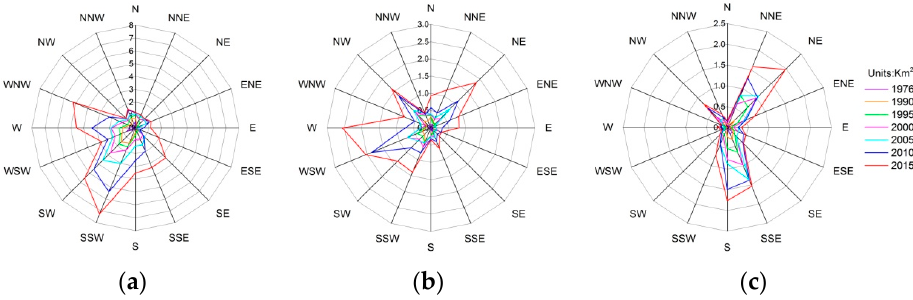
Figure 4. Spatial orientation of urban expansion, 1976 to 2015. ( a ) The city proper; ( b ) the county town of Menghai; ( c ) the county town of Mengla.